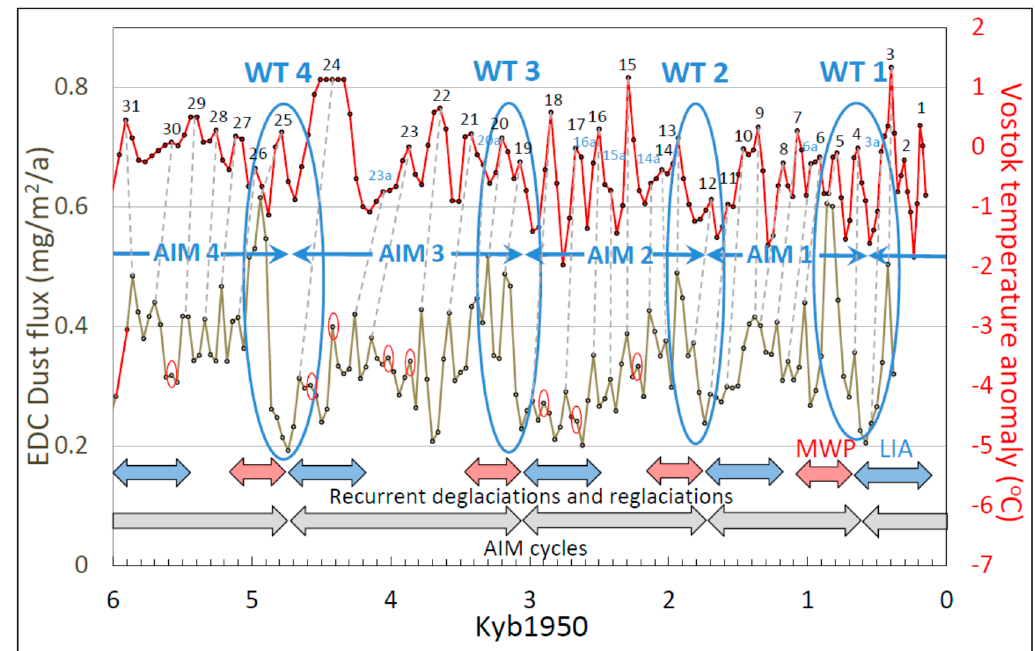
Figure 6. One-to-one coupling between wind proxies (dust flux) at EPICA Dome C (EDC) (lower brown curve) and temperature anomaly computed from deuterium excess at Vostok (upper red curves) over the last six millennia. Dashed lines connect wind-proxy peaks with corresponding temperature-proxy peaks, which are numbered according to the quantitative ACO/AAO cycle nomenclature developed earlier [12]. Red ovals enclose wind-proxy cycles that are unmatched in the temperature-proxy record (see text). Temperature extremes hindcasted in register with the Wind Terminus (WT) of the Antarctic Centennial Wind Oscillation (ACWO) are shown by colored bidirectional horizontal arrows (red = warm, blue = cold). The red segment of the otherwise brown wind-proxy curve at 6000-5900 years before 1950 (Yb1950) denotes a period of missing data that was filled by interpolation for visual but not analytic purposes. Additional abbreviations: AIM, Antarctic Isotope Maximum; MWP, Medieval Warm Period; LIA, Little Ice Age; WT, Wind Terminus.